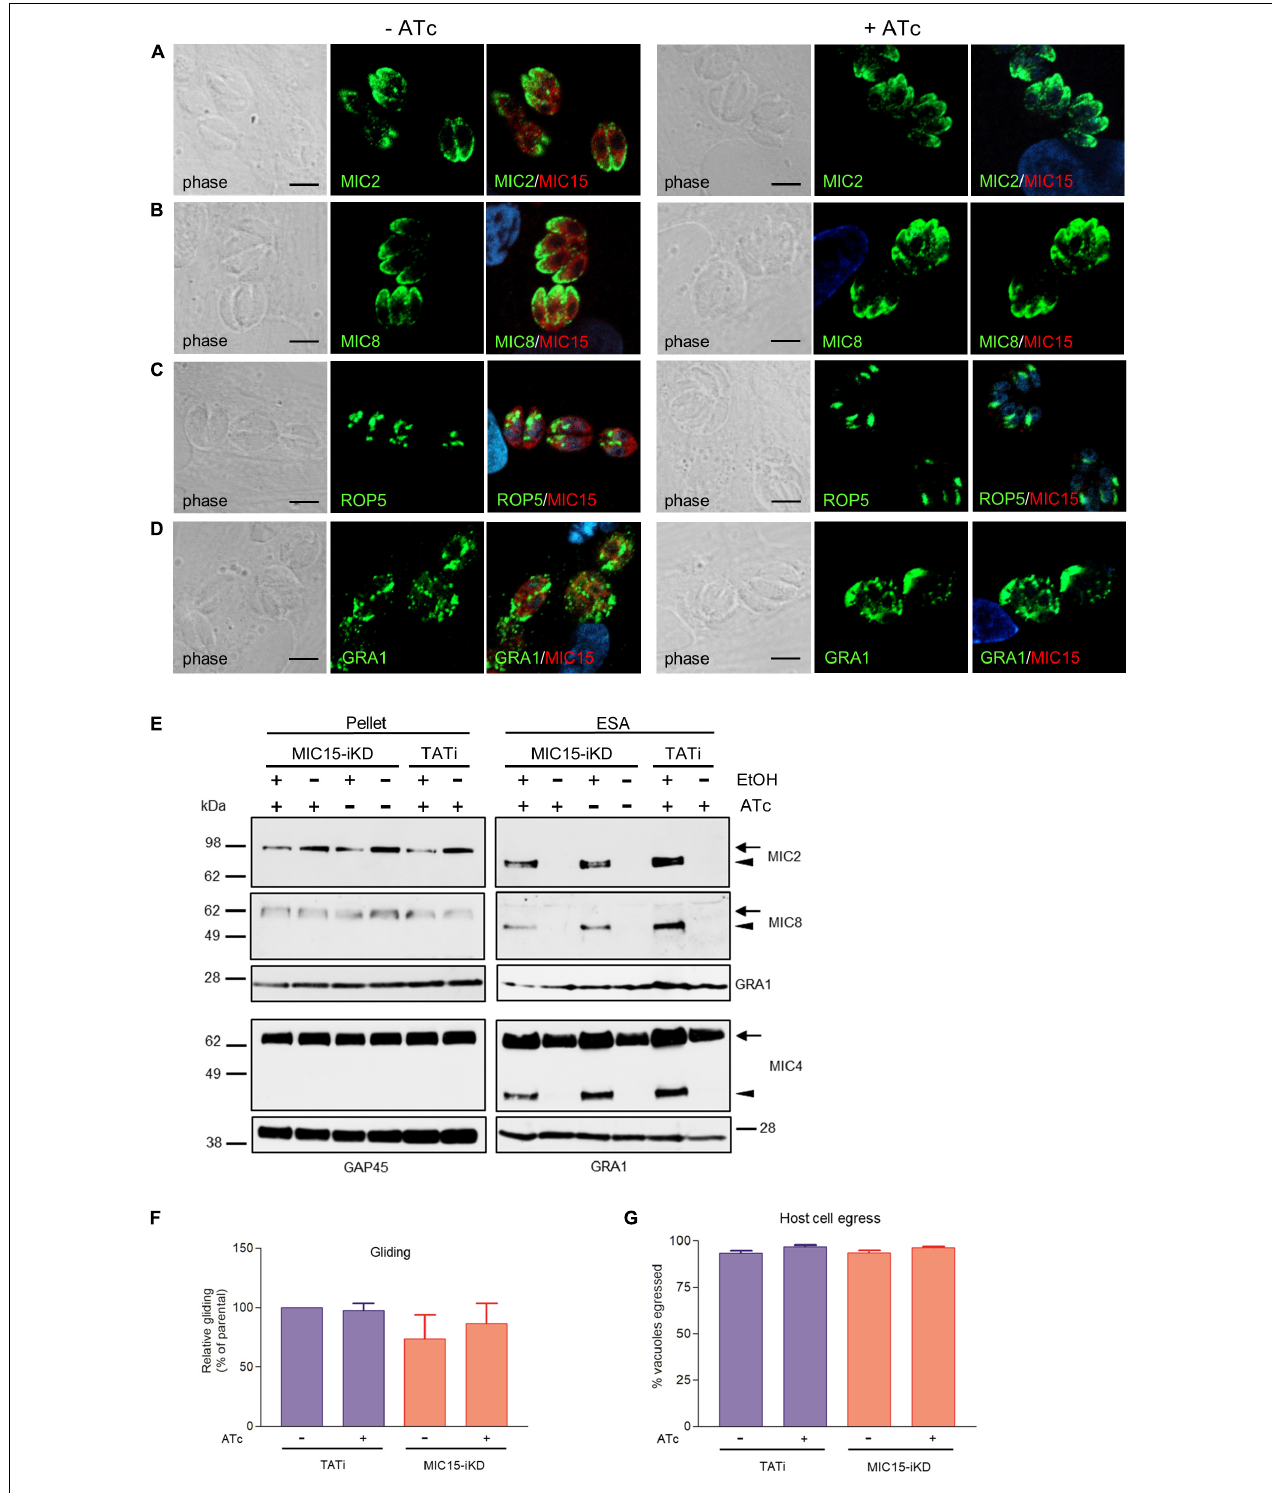
FIGURE 5 | Impact of MIC15 depletion on organelle localization and microneme-dependent functions. (A–D) Immunolocalization of secretory proteins in MIC15-iKD tachyzoites grown in presence or absence of Atc for 60 h. The parasites were stained with rabbit serum MIC15Nt plus a mAb specific for either MIC2 (Achbarou et al., 1991) (A) , MIC8 (Meissner et al., 2002a) (B) , ROP5 (C) , or GRA1 (Sibley et al., 1995) (D) . Nuclei are stained with DAPI. Space bar, 5 µ M. (E) Western blot analysis of constitutive and ethanol-induced microneme secretion in MIC15-iKD parasites. The presence of MIC2, MIC4 (Reiss et al., 2001) and MIC8 was revealed